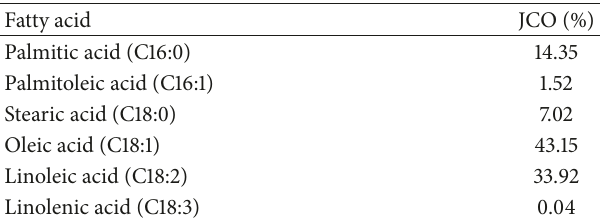
Table 6: Fatty acid composition analysis of